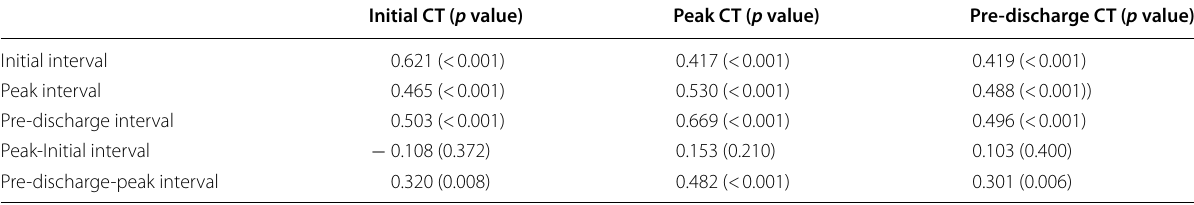
Table 2 Correlation coefficient between intervals and score of lobes percentage on initial, peak, and pre‑discharge CTs of COVID‑19